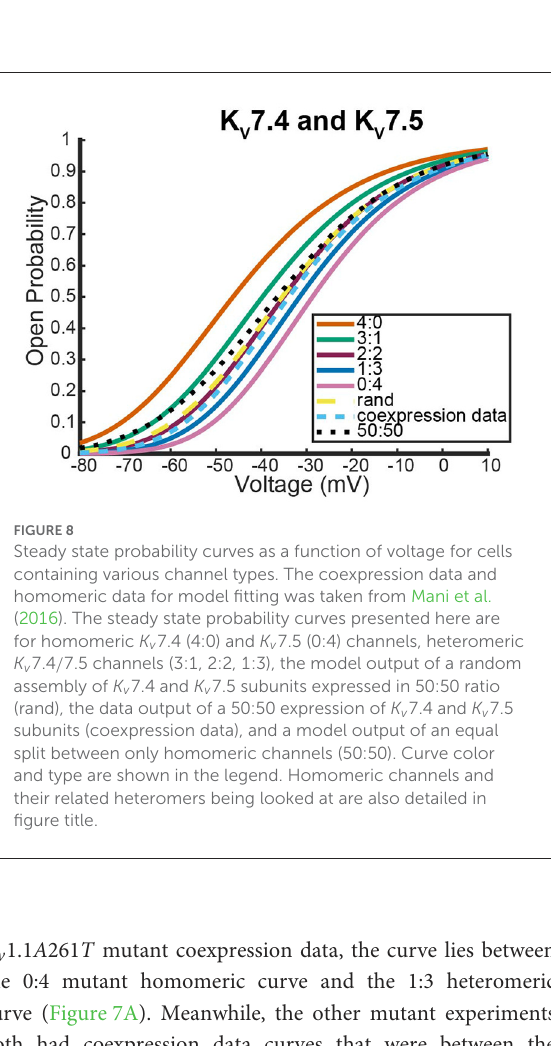
experiment of K v 7.4 and K v 7.5 DNA done by Mani et al.